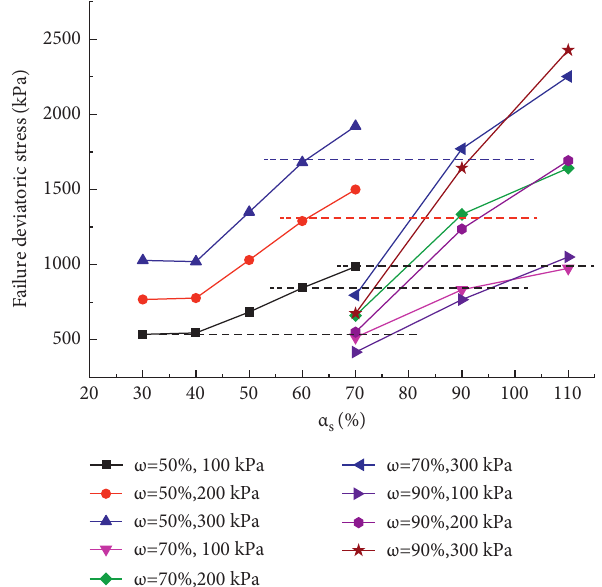
Figure 12: Relationship between failure deviatoric stress and steel slag incorporation.